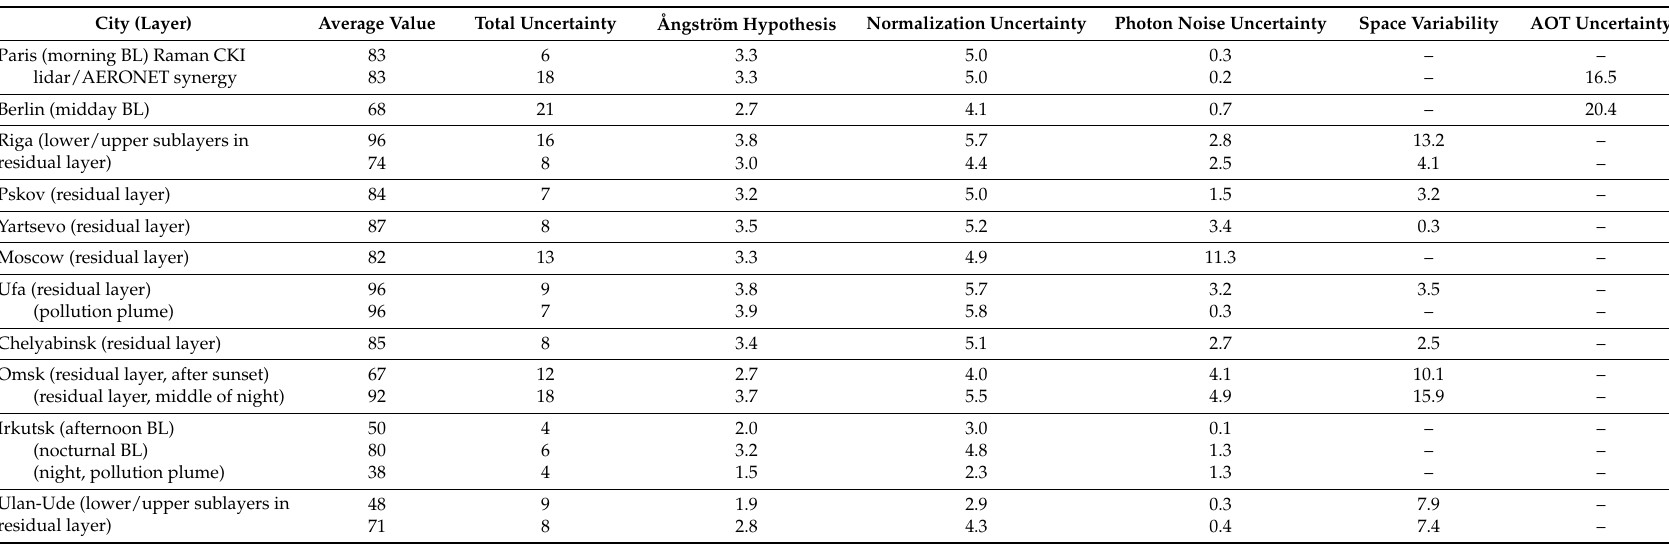
Table A1. Error budget on the LR values presented in Table 2, following the process described in Section 3.1. All values are in steradians (sr). Columns 3 to 8 are all absolute uncertainties. Depending on the retrieval method used, the types of uncertainties that are not relevant are signaled by a